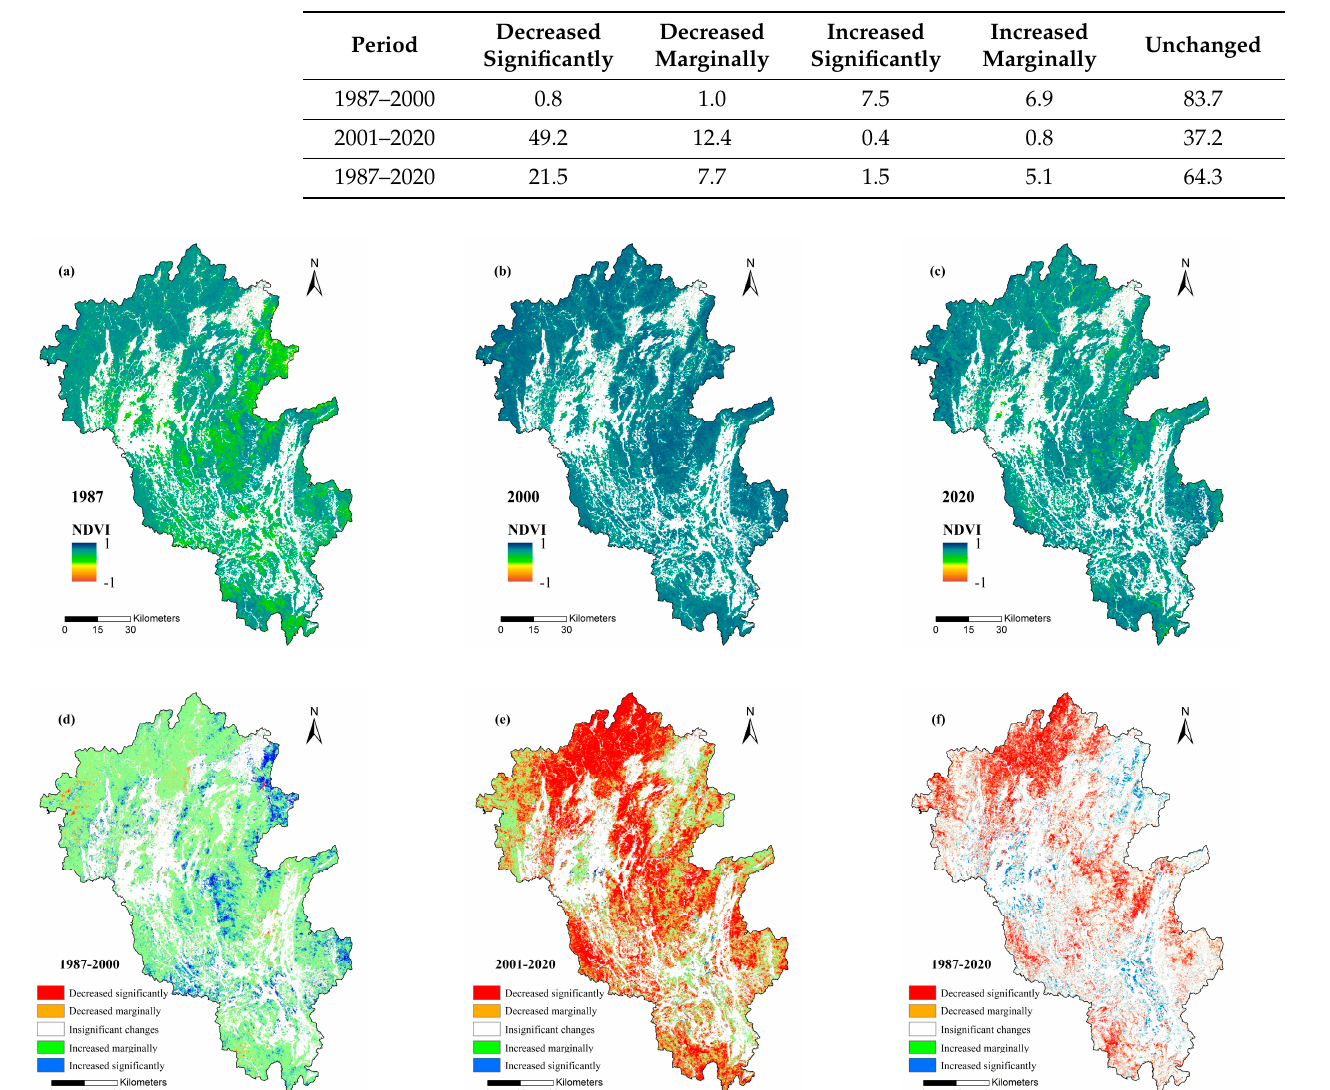
Figure 4. Spatial distribution of NDVI in forest areas in ( a ) 1987; ( b ) 2001; ( c ) 2020 and the change trend of annual NDVI covering ( d ) 1987 − 2000; ( e ) 2001 − 2020; ( f ) 1987 − 2020.